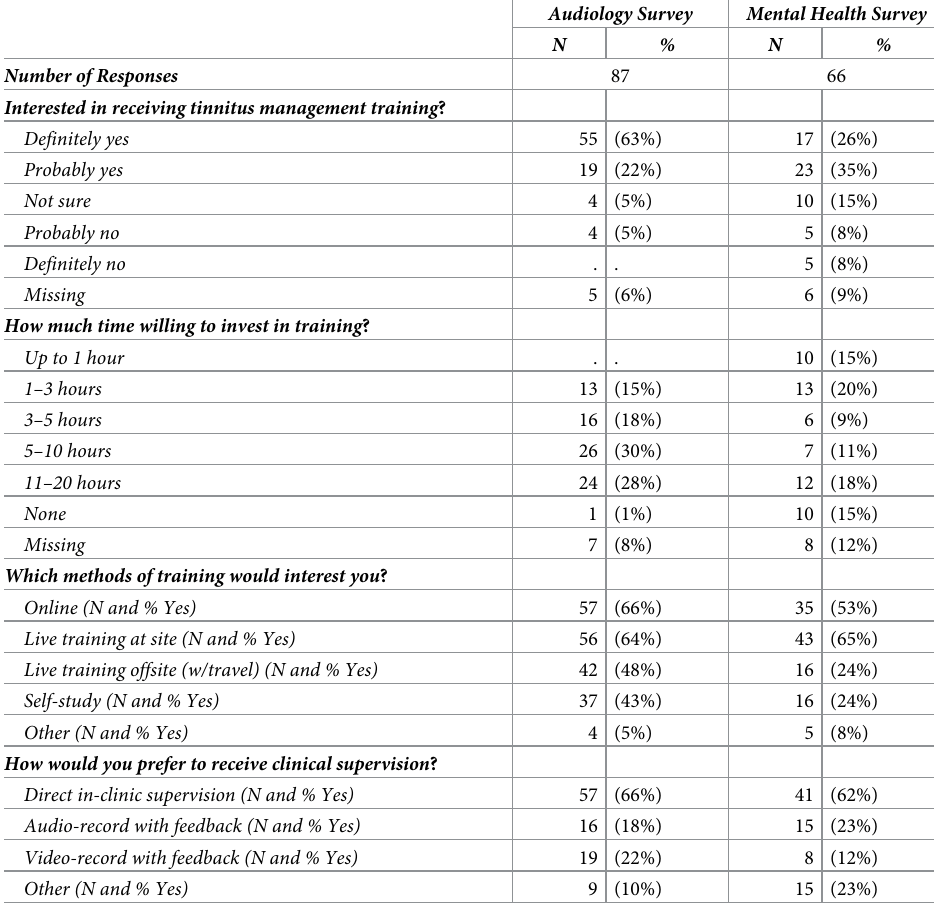
Table 3. Respondents’ preferences for receiving tinnitus management